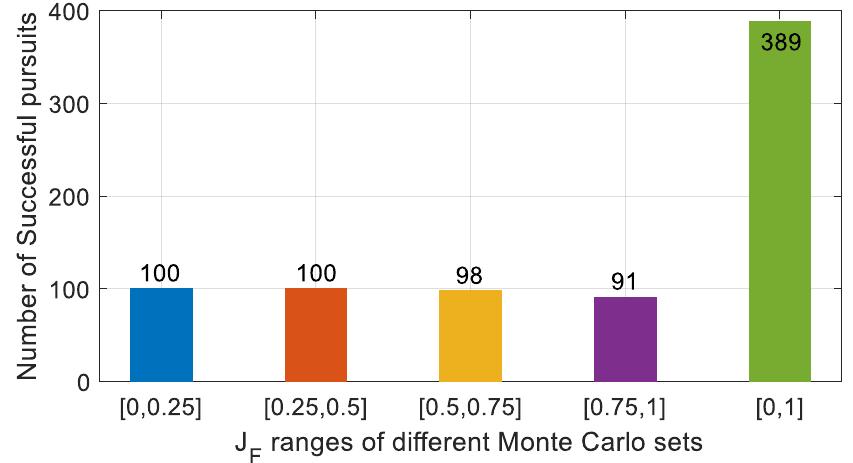
Figure 14. Number of successful pursuits for scenarios with different J F using DDPG.